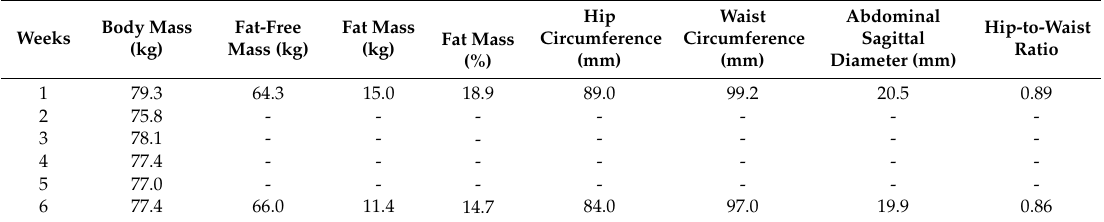
Table 3. Body mass, fat-free mass, fat mass, hip circumference, waist circumference, abdominal sagittal diameter (mm) and hip-to-waist ratio changes for 6